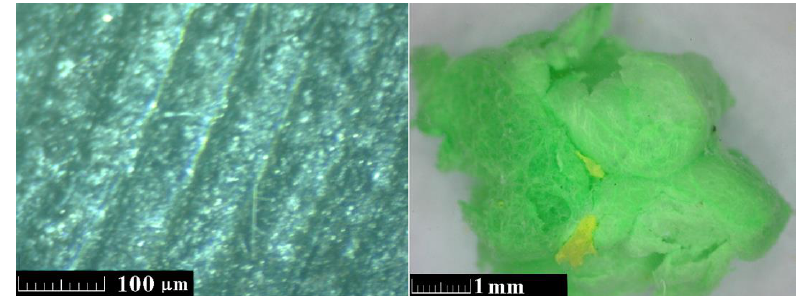
Figure 5. Optical microscopy images of the EPP particle.